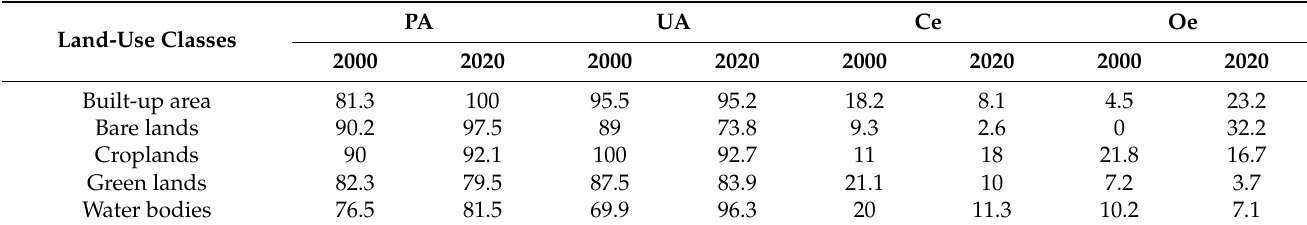
Table 2. Accuracy assessment of image classifications for the years 2000 and 2020.